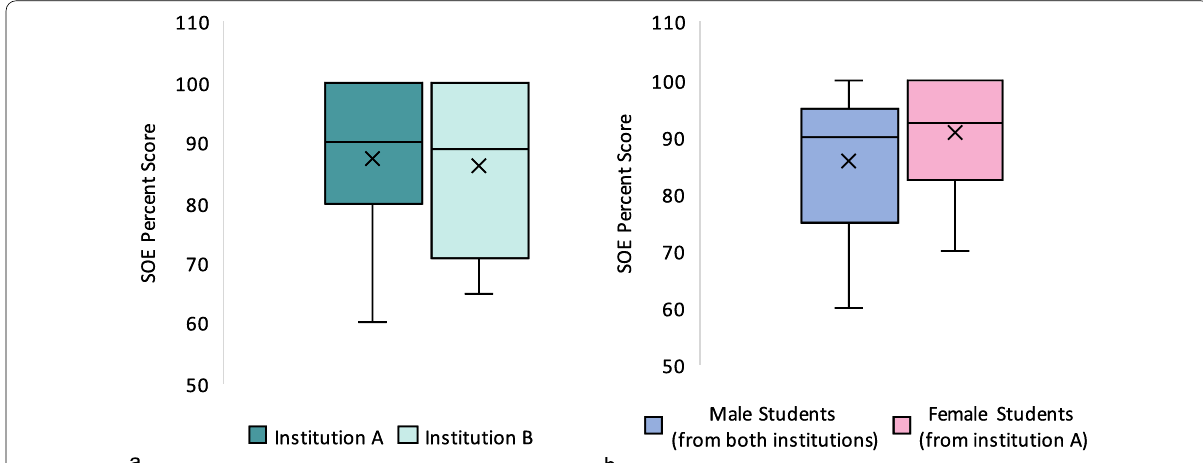
Fig. 5 Comparison of boxplots of SOE percent scores between the two institutions ( a ) and between male and female students ( b ). There was no statistically significant difference between these